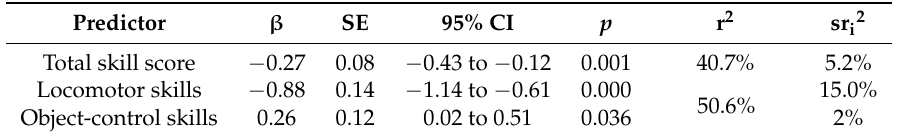
Table 3. Results from linear regressions with fundamental movement skills as predictors of percentage body fat (adjusting for sex, maturity offset, ethnicity, deprivation). Predictor β SE 95% CI p r 2 sr i2 Total skill score −